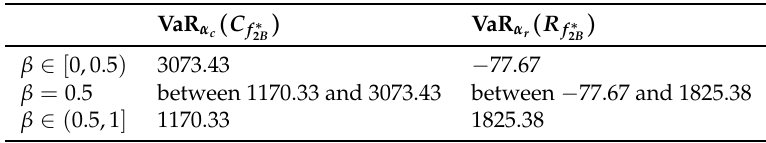
Table 4. VaRs of the cedent and the reinsurer when f ∈ C 2 .